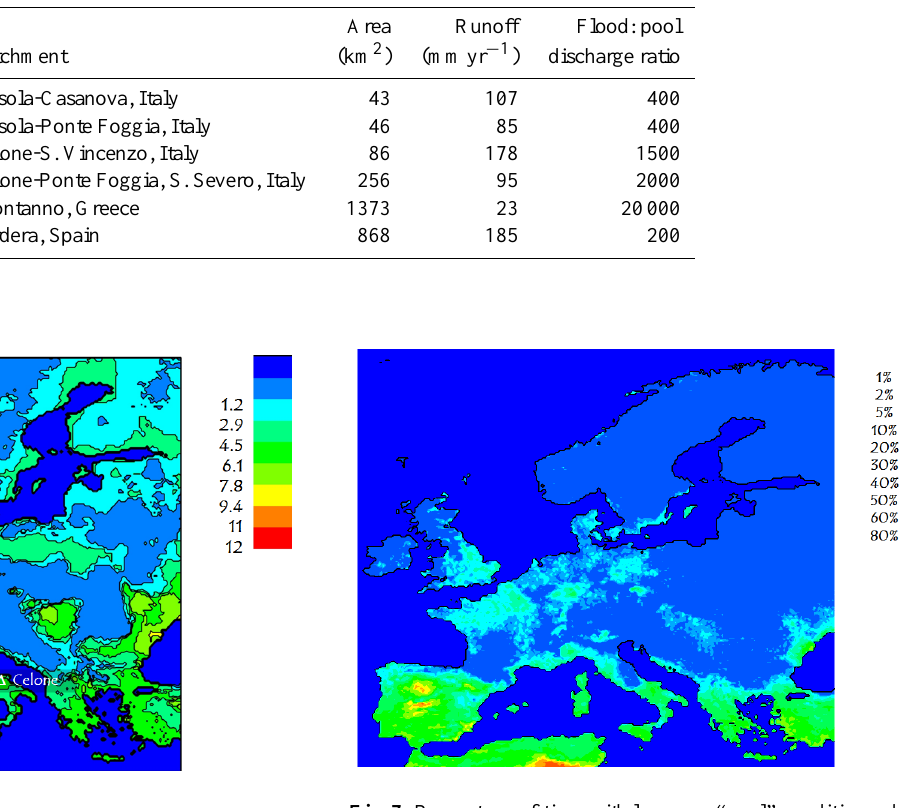
Fig. 5. Average number of months with Precipitation < 0.6 Potential ET. Figure also shows location of test catchments.